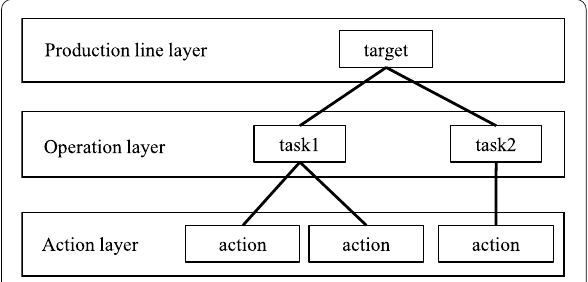
Figure 2 Three-layers structure of human–robot interaction operations model